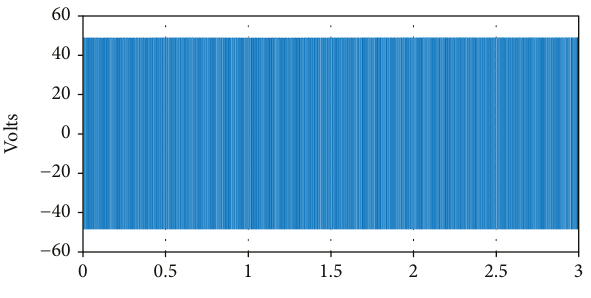
Figure 21: Inverter output voltage.